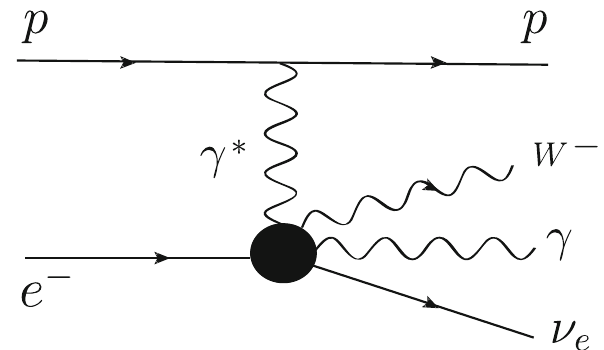
Fig. 1 Feynman diagram for the signal process e − p → e − γ ∗ p → pW − γν e . New physics (represented by a black circle) in the elec- troweak sector can modify the quartic gauge couplings